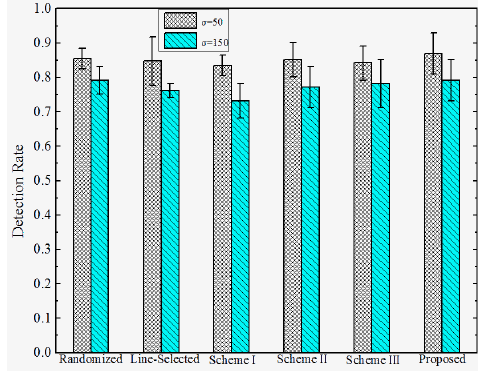
Figure 10. Detection rate of the proposed versus prior works under attack strategy II when D = 200.